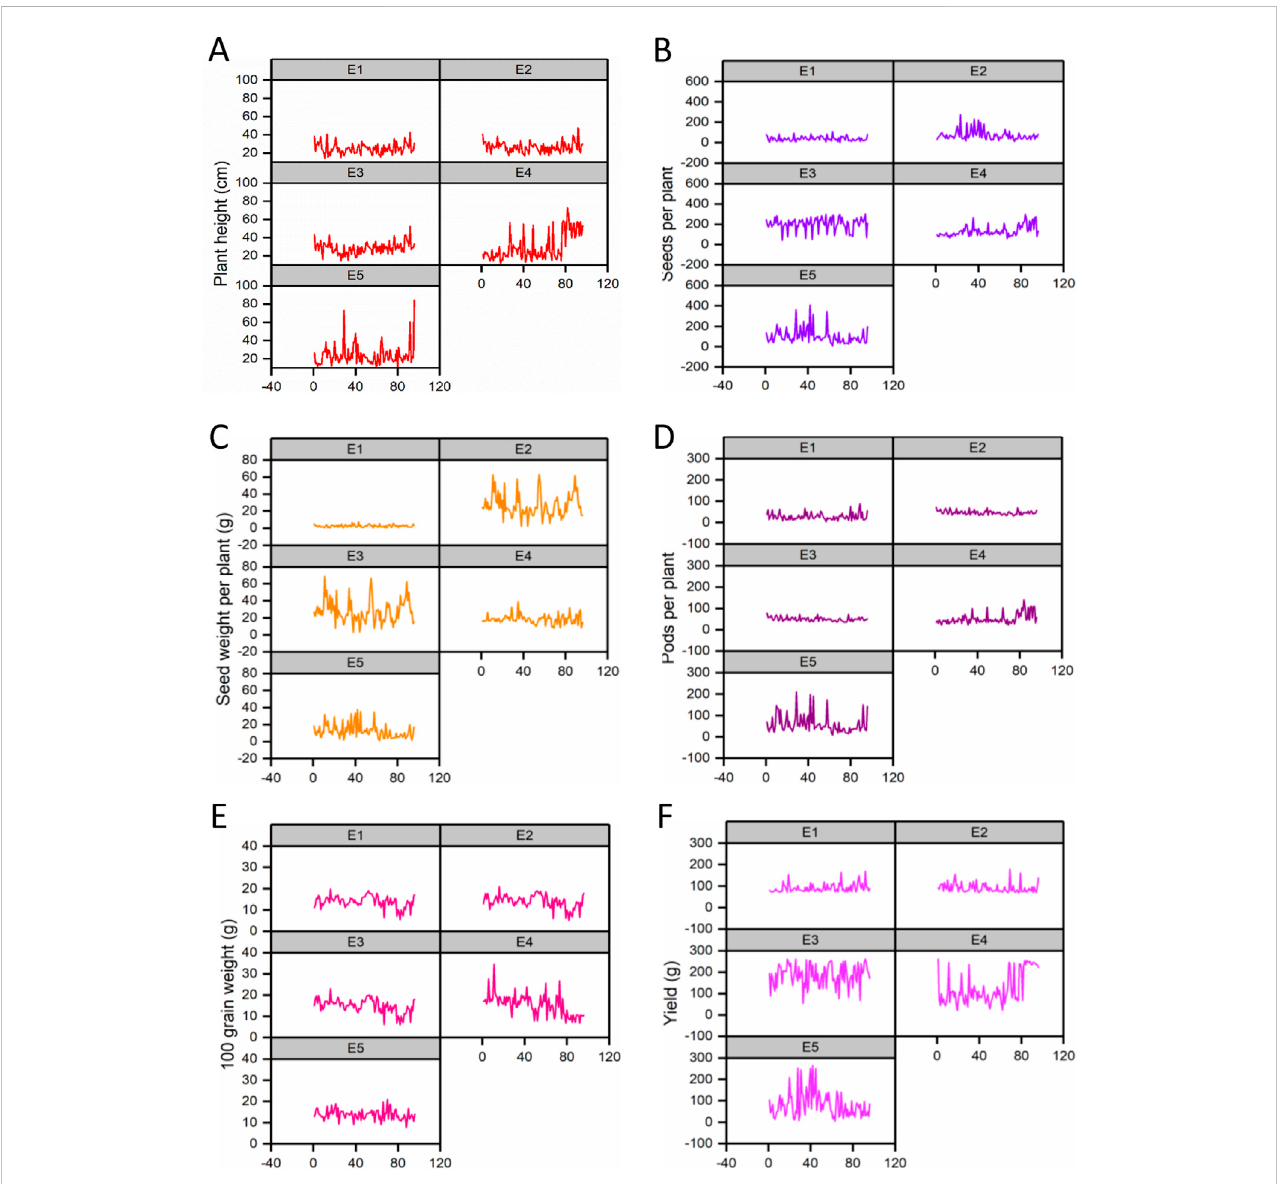
FIGURE 2 Variationinphenotypicdatafortraitsisshownintrellisplots. (A) Plantheight(PH). (B) Podsperplant(PPP). (C) Seedsperplant(SDPP). (D) Seedweightper plant (SWPP). (E) Hundred-grain weight (HGW). (F) Total yield